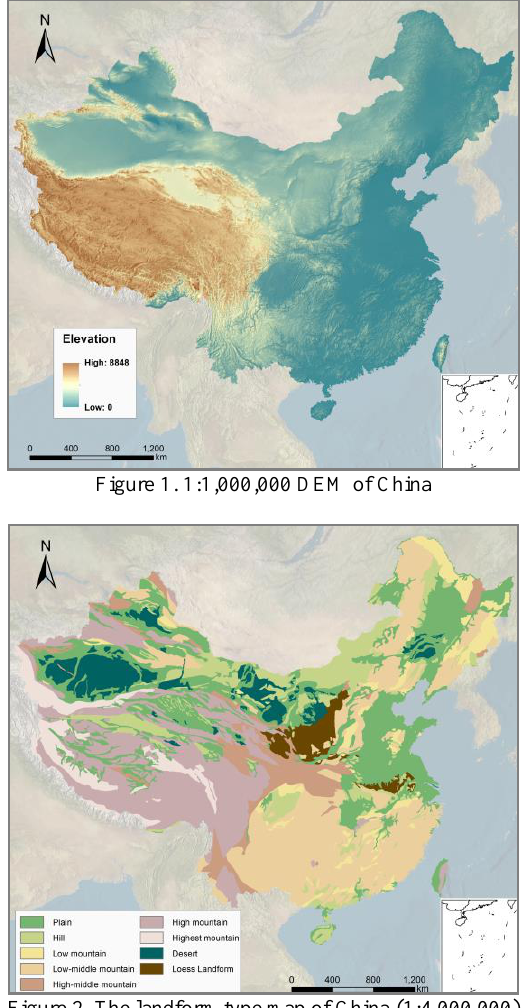
Figure 2. The landform type map of China (1:4,000,000)